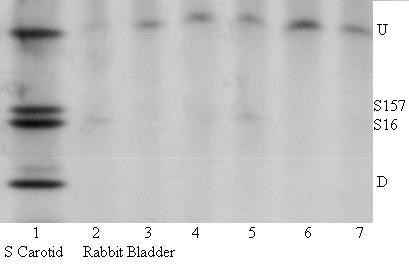
Representative HSP20 immunoblot of homogenates from a swine carotid tissue (lane 1, 15 μl loaded) and six different rabbit bladder tissues (lanes 2–7, 30 μl loaded). The bands have been identified in swine carotid as unphosphorylated (labeled U), monophosphorylated at serine 157 (labeled S157), monophosphorylated at serine 16 (labeled S16), diphosphorylated at serine 16 and 157 (labeled D), There was significantly less HSP20 immunostaining in the bladder compared to swine carotid, suggesting that the HSP20 in bladder could come from contaminating vasculature.